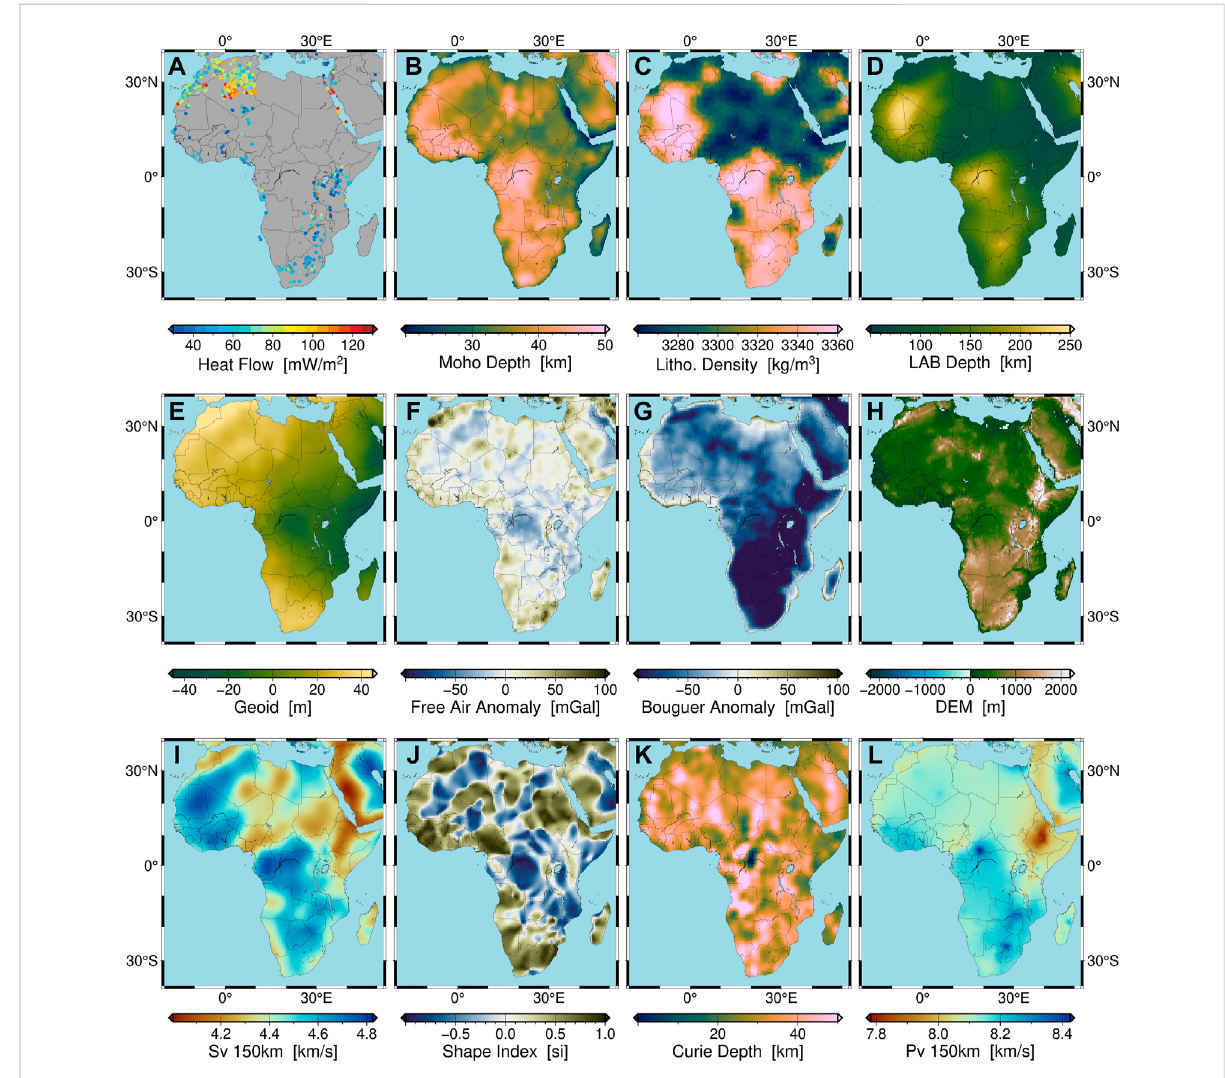
FIGURE 3 Illustration of the observables used in this study (A) Measured GHF, (B) Moho depth, (C) Lithospheric average density, (D) Lithosphere – AsthenosphereBoundary(LAB)depth, (E) Geoid, (F) Freeairgravityanomaly, (G) Bougueranomaly, (H) DigitalElevationModel(DEM), (I) S v velocity, (J) Shape index, (K) Curie temperature depth, (L) P v